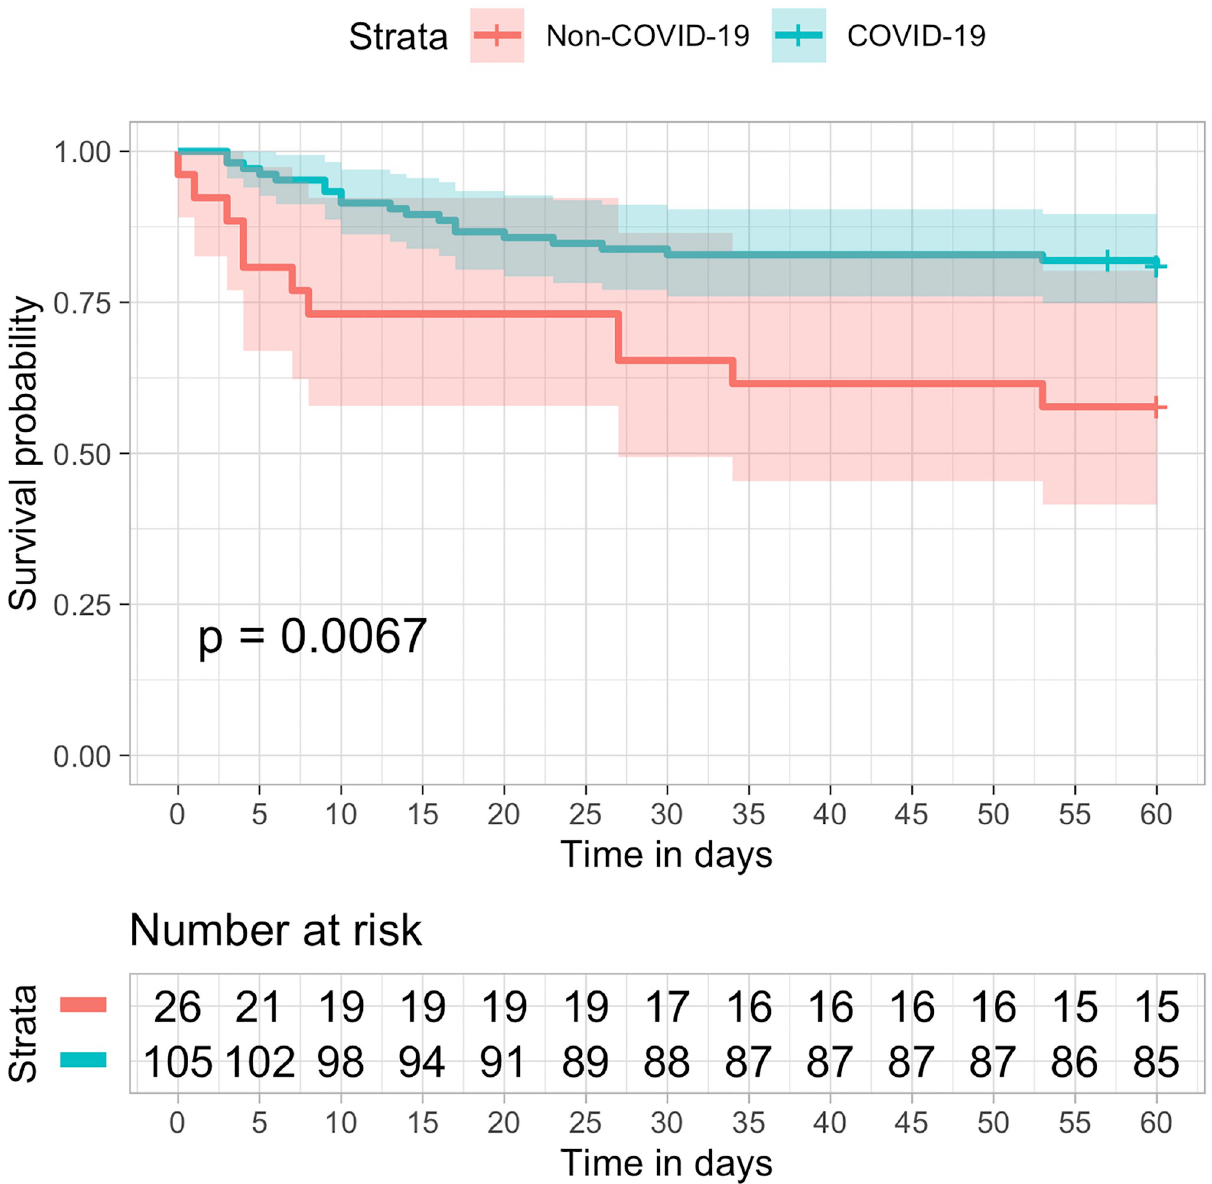
Fig 5. Kaplan–Meier estimates of all-cause survival rate up to 60 days in ventilated patients. Overall survival was longer in COVID-19 (blue) as compared to non-COVID patients (orange) in the previous year (logrank p =